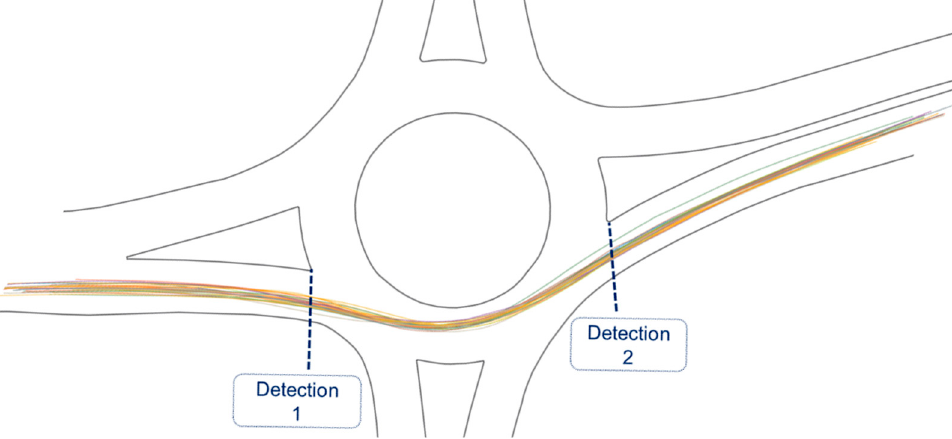
Figure 9. Graphical representation of the vehicle trajectories and the location of coded detectors.